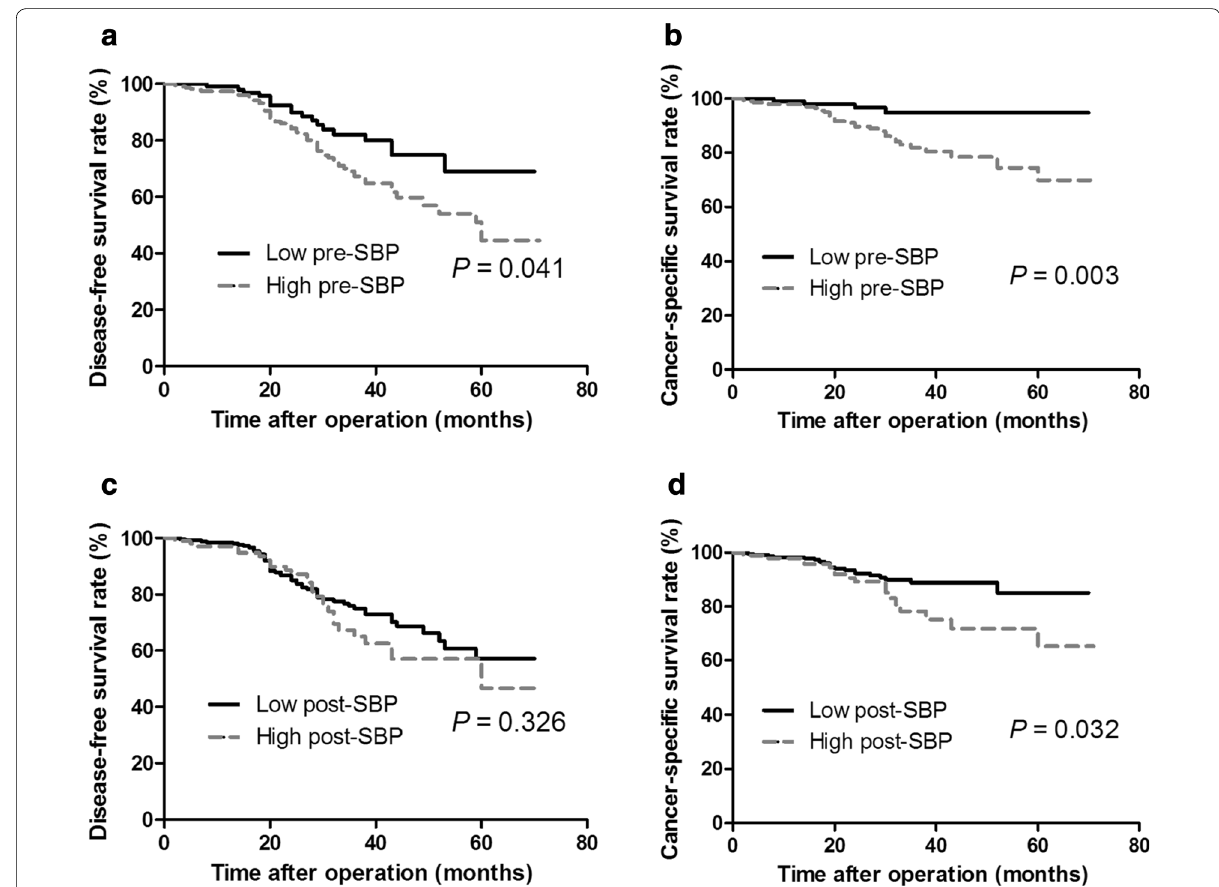
Fig. 2 Kaplan–Meier survival curves of rectal cancer patients with different preoperative and postoperative BPs. The curves showed significantly lower DFS ( a ) and CSS ( b ) rates in the high‑preoperative SBP group than in the low‑preoperative SBP group. Patients in the high‑postoperative SBP group had significantly lower CSS ( d ) rates, whereas the differences in the DFS curves ( c ) were not significant. SBP systolic blood pressure, DFS disease‑free survival, CSS cancer‑specific